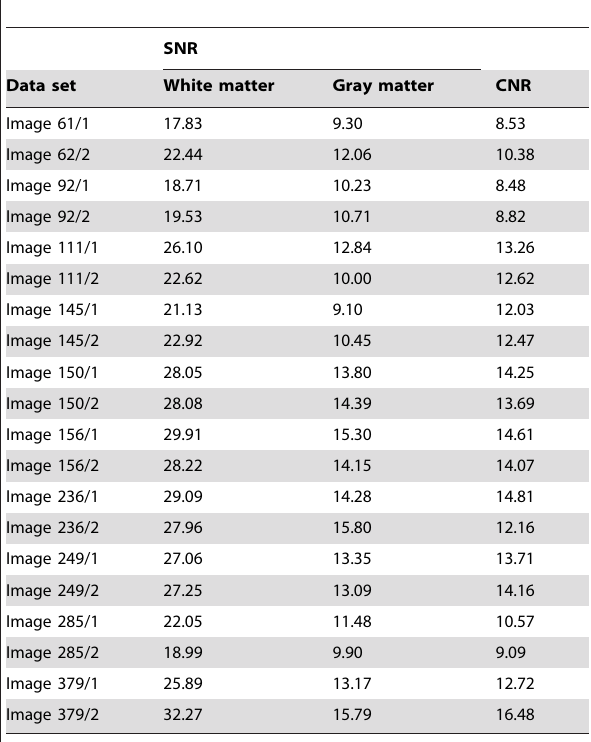
Table 4. Image quality parameters of the OASIS data